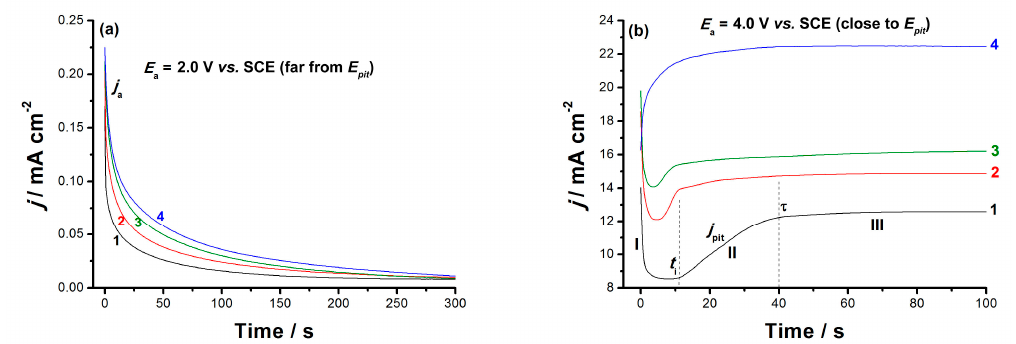
Figure 9. Chronoamperometry (current–time) curves recorded for the studied solder alloys in 0.9% NaCl solution at applied anodic potentials of 2.0 V ( a ) and 4.0 V ( b ) vs. SCE at 37 ◦ C: (1) pure Ti; NaCl solution at applied anodic potentials of 2.0 V (a) and4.0 V (b) vs. SCE at 37 °C: (1) pure Ti; (2) (2) Ti-6Al-7Nb; (3) Ti-6Al-4V; and (4) TC21. Ti-6Al-7Nb; (3) Ti-6Al-4V; and (4) TC21.